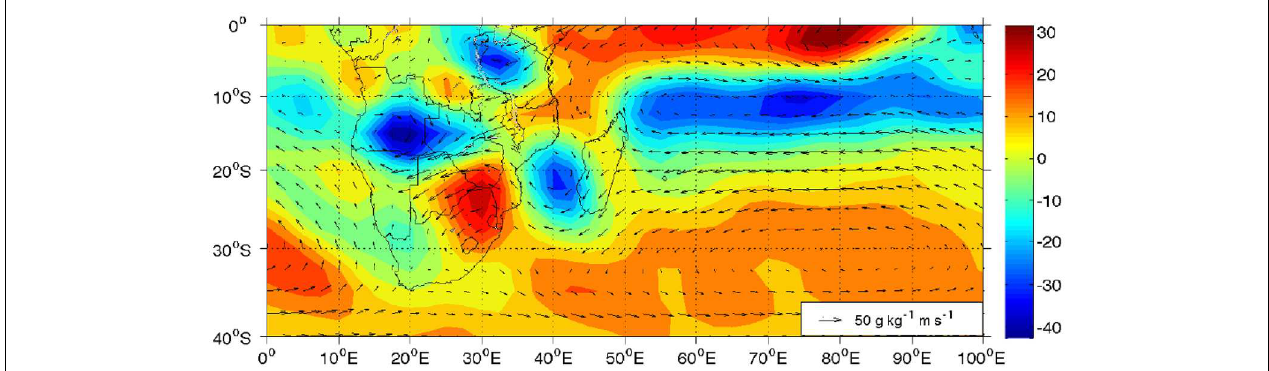
FIGURE 2 | Climatological moisture flux and divergence for February–April at the 850 hPa level computed from NCEP re-analyses for 1980–2010. A scale moisture flux vector is given.